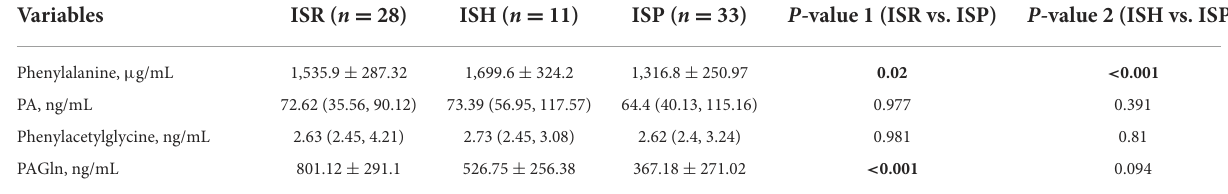
TABLE 2 Levels of plasma metabolites.